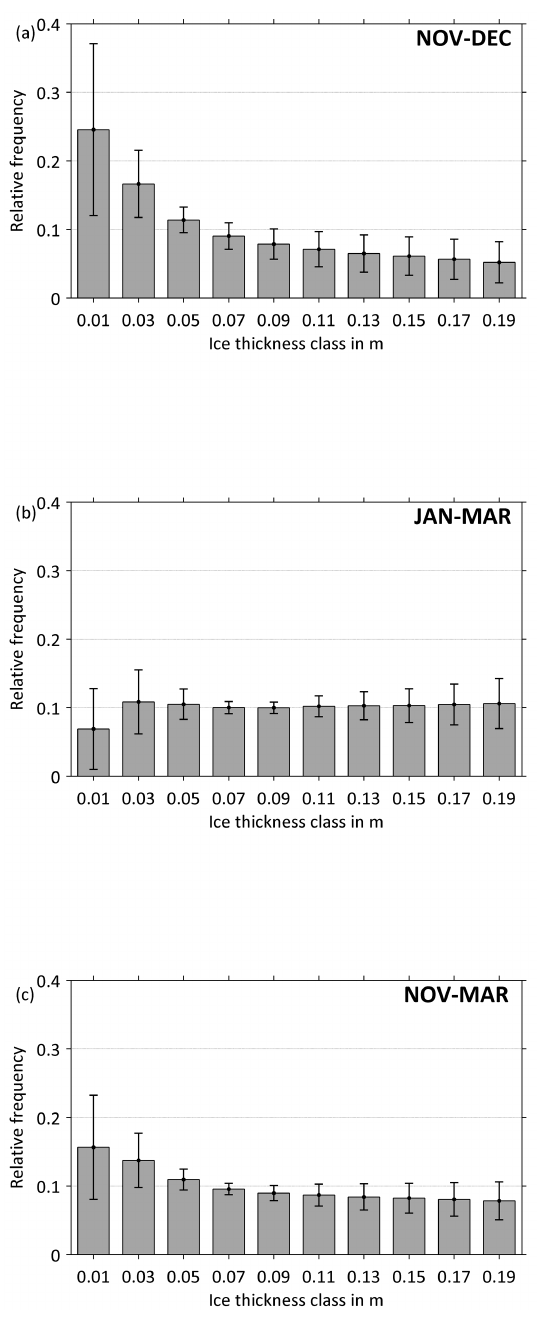
Figure 4. Relative thin-ice thickness (TIT) distribution in the Stor- fjorden polynya, with ice-thickness classes of 2cm range ( x axis). Input data are based on daily TIT composites. The bars indicate the mean relative distribution of each thickness class from the to- tal number of TIT ≤ 0.2m appearances between the winter sea- sons 2002/2003 and 2013/2014. Error bars refer to ± 1SD. Besides an overview of the complete freezing season from November to March (c) , it is further separated between the months November and December (a) as well as January to March (b) .